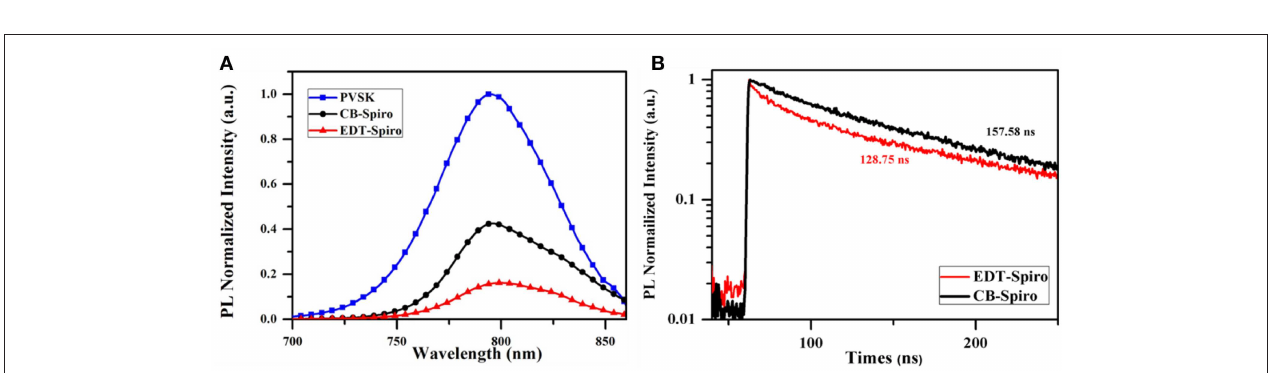
FIGURE 3 | (A) Photoluminescence spectrum of glass/FTO/SnO 2 /PVSK/CB-Spiro and glass/FTO/SnO 2 /PVSK/ EDT-Spiro, respectively. (B) Time-resolved photoluminescence spectra (at 795nm) of the CB-Spiro and EDT-Spiro films, respectively.